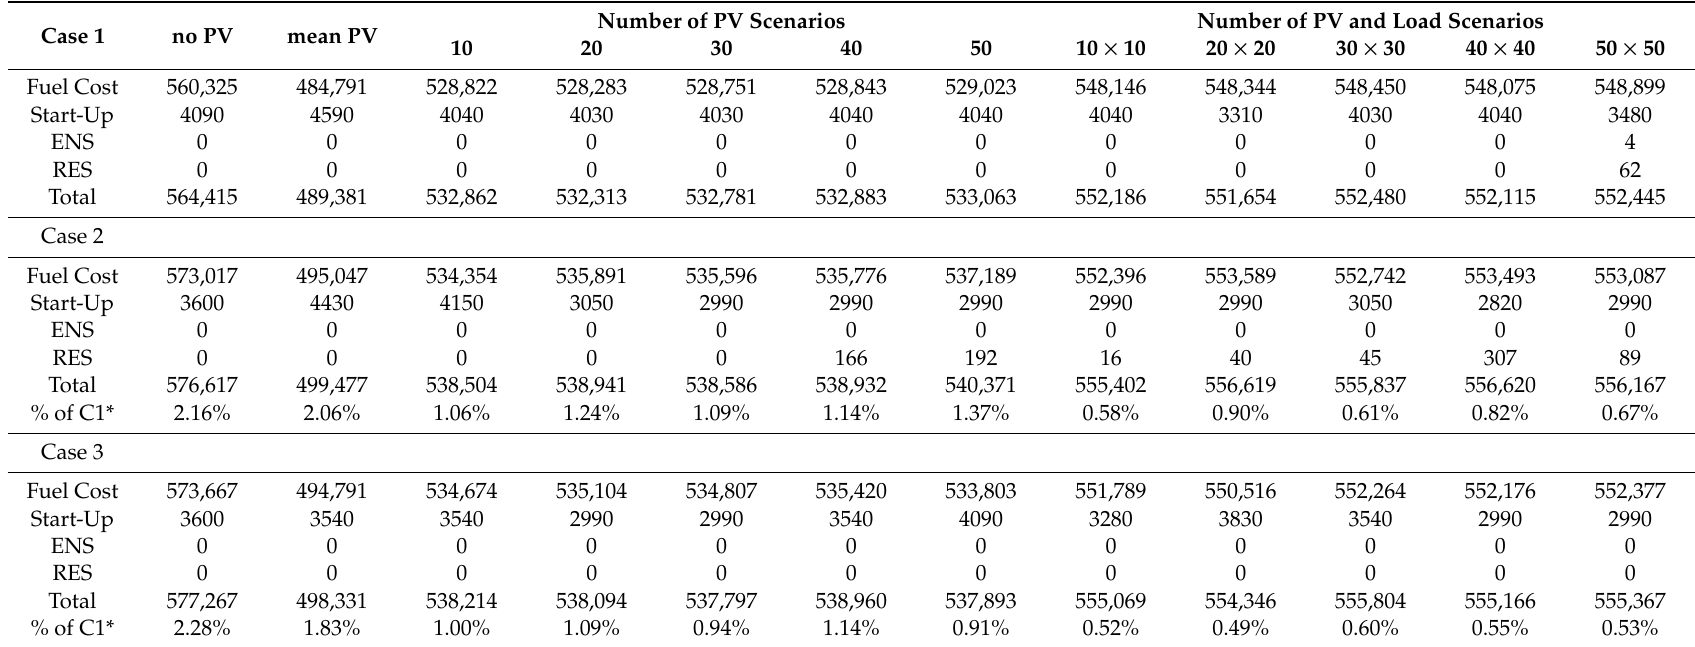
Table 2. Day-ahead unit commitment cost of the three cases for di ff erent scenario